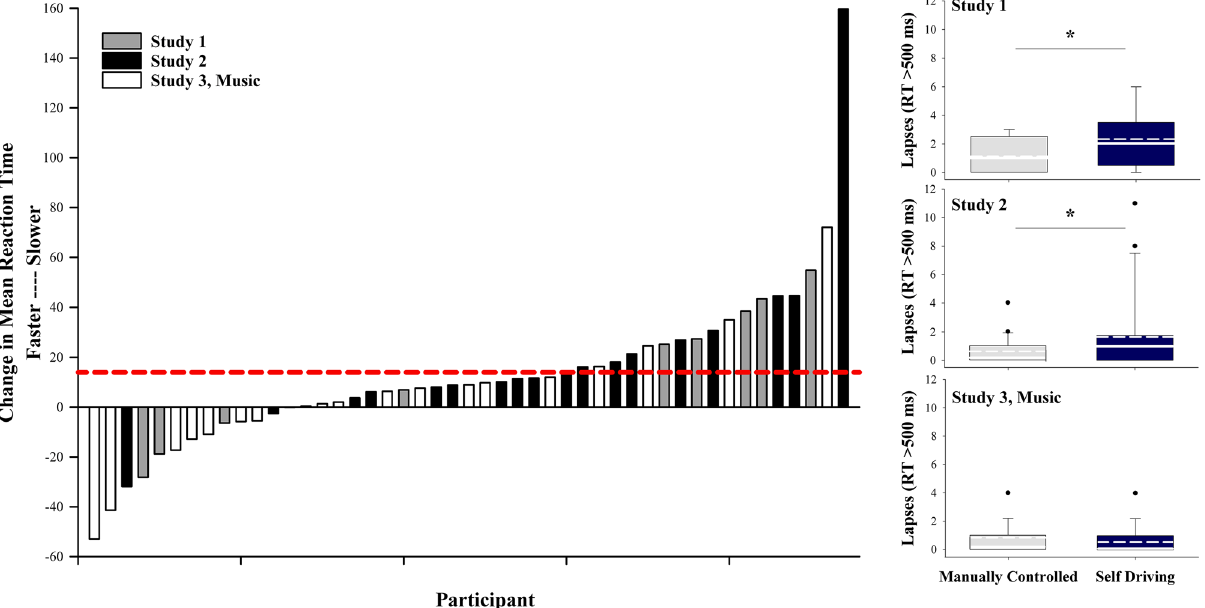
Figure 3. Mean reaction time and lapses of attention following the manually controlled and self-driving conditions. Left panel: Change in mean reaction time following the self-driving compared to the manual-driving condition by individual participant. Higher values indicate slower reaction times. The red dashed line indicates reaction time slowing by 15 ms, which is the equivalent increase in reaction time observed in those with a blood alcohol concentration of 0.5 g/L relative to placebo. Right panel: Lapses (reaction time [RT] > 500 ms) following the manually controlled and self-driving conditions. Higher values indicate more lapses in attention. For each box, the solid white line indicates the median, the dashed white line indicates the mean, and the bottom and top boundaries of the box indicate the 25th and 75th percentiles, respectively. The bottom and top whiskers indicate the 10th and 90th percentiles, respectively (Study 1 n = 9; Study 2 n = 19; Study 3 n = 19). * = p <